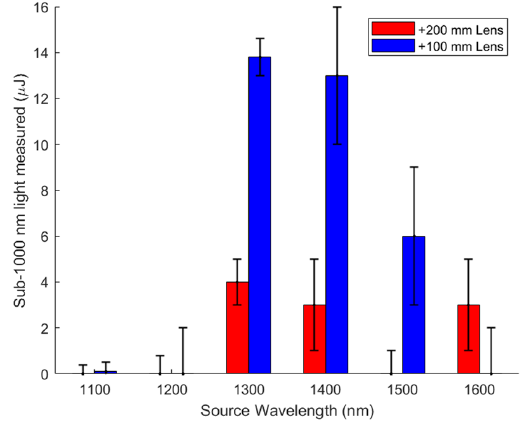
Figure 4. Sub-1000 nm light generation collected from power meter (P) in the experimental setup in Fig. 1(b). Input pulse energy for each source wavelength is the max pulse energy listed in Table 2. The starting beam diameter of each pulse is also listed in Table